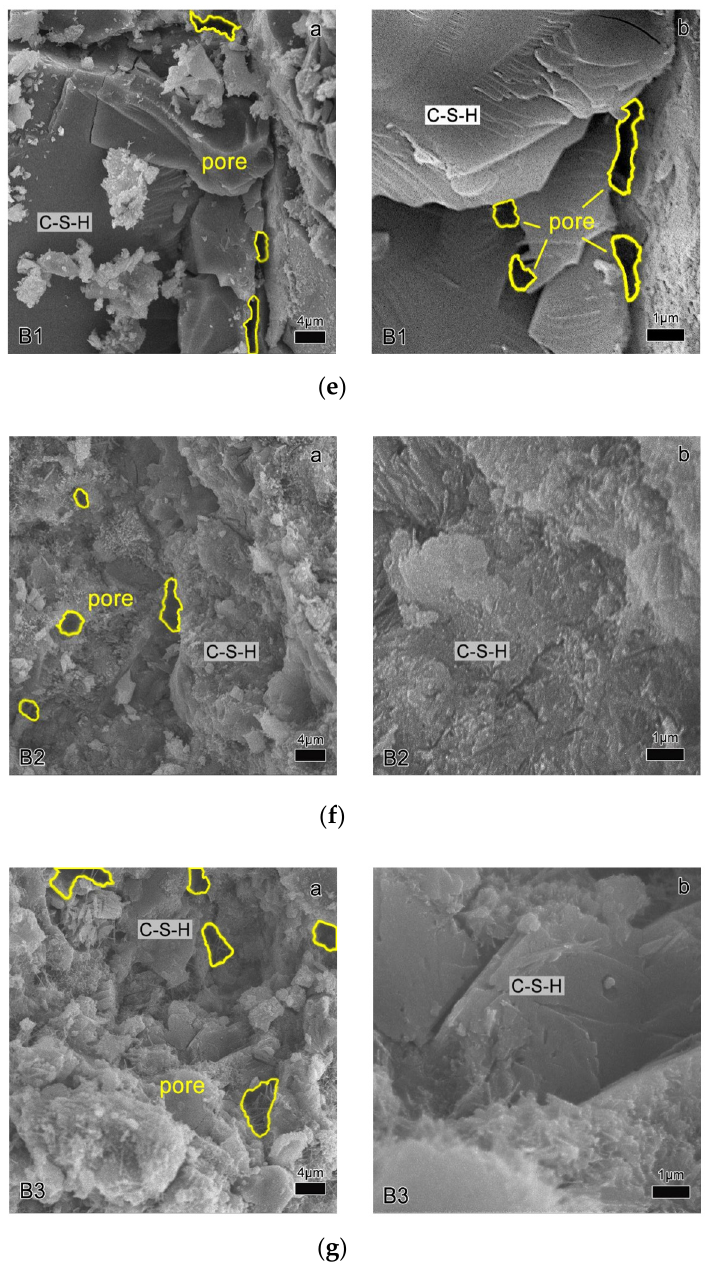
Figure 11. The analysis of the material morphology of RTIC based on SEM (2.0 k to 10.0 k). ( a ) RCE0GHB0; ( b ) RCE10GHB0; ( c ) RCE20GHB0; ( d ) RCE30GHB0; ( e ) RCE10GHB20; ( f ) RCE10GHB40; ( g )